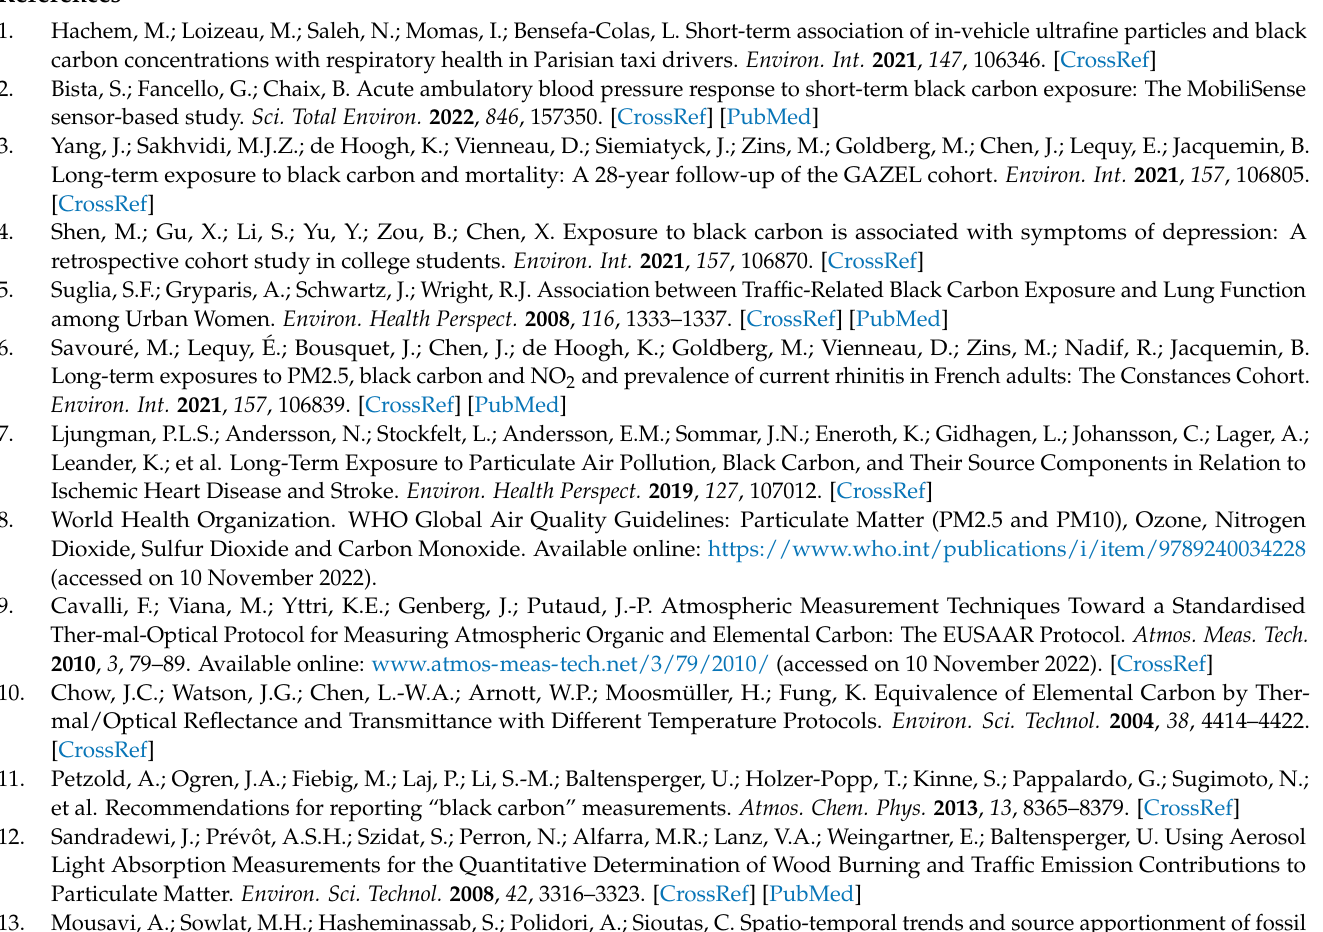
Figure A9. Time series plot of hourly BC wf source contributions, 2020 campaign.